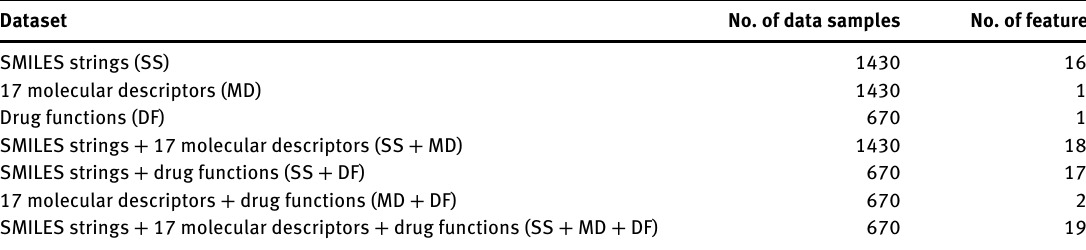
Table 1: Dataset